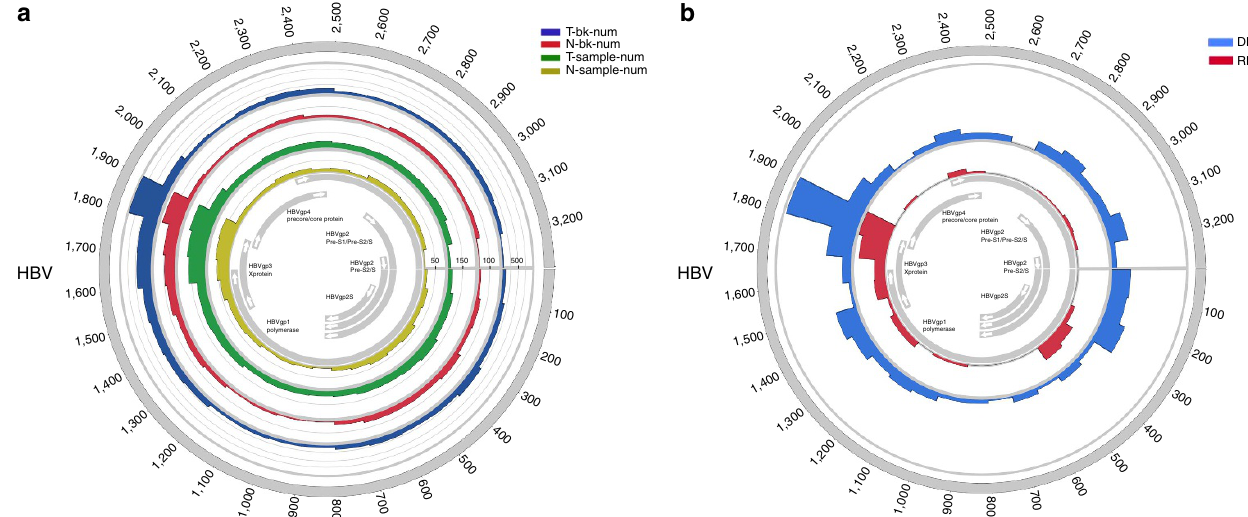
Figure 4 | Distribution of integration breakpoints in the HBV genome. ( a ) Distribution of integration breakpoints in the HBV genome in 426 paired samples. Each bar represents the number of HBV integration breakpoints (Tumour: blue, Normal liver tissue: red) or sample frequency (tumour: green, normal liver tissue: yellow) at a particular locus in HBVgenome. Histograms were constructed for 100-bp intervals. Histogram axis units represent number of breakpoints, and outer DNA numbering is given in bases. HBV genes with different functions are shown. ( b ) Distribution of integration breakpoints of both DNA and RNA level of 12 paired samples. Histograms were constructed for 100-bp intervals. The number of HBV integration of RNA (red) and DNA (blue) level are shown on the inner and outer circles. Histogram axis units represent number of breakpoints, and outer DNA numbering is given in bases. HBV genes with different functions are